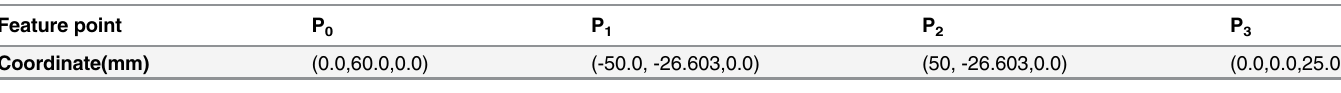
Table 2. Coordinate of feature